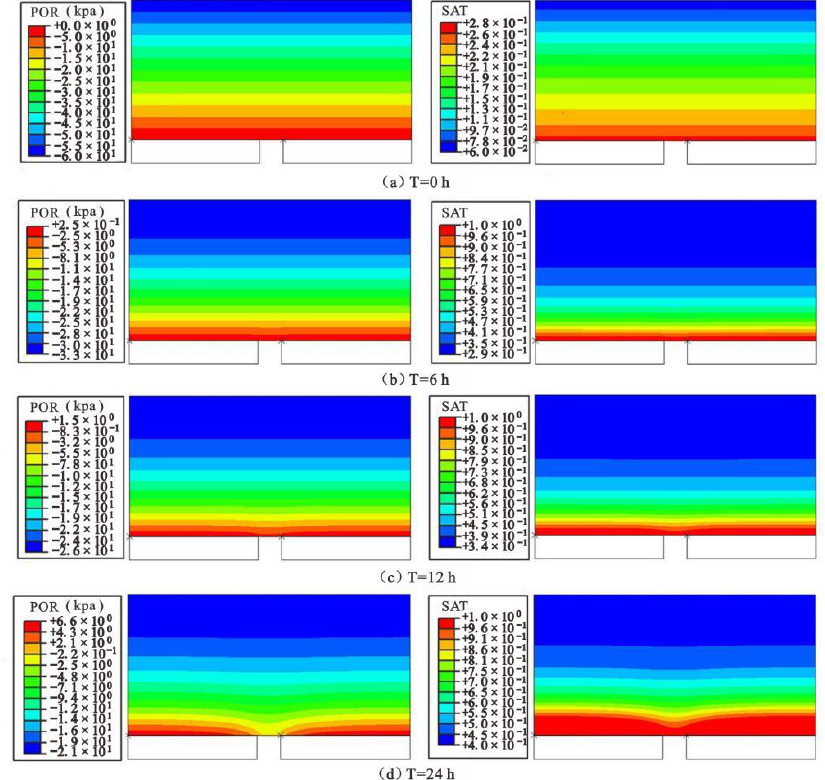
Figure 13. Pore water pressure and saturation contour plots. ( a ) is the initial pore water pressure and saturation contour plots; ( b – d ) are the pore water pressure and saturation contour plots in 6 h, 12 h and 24 h after the start of rainfall respectively.